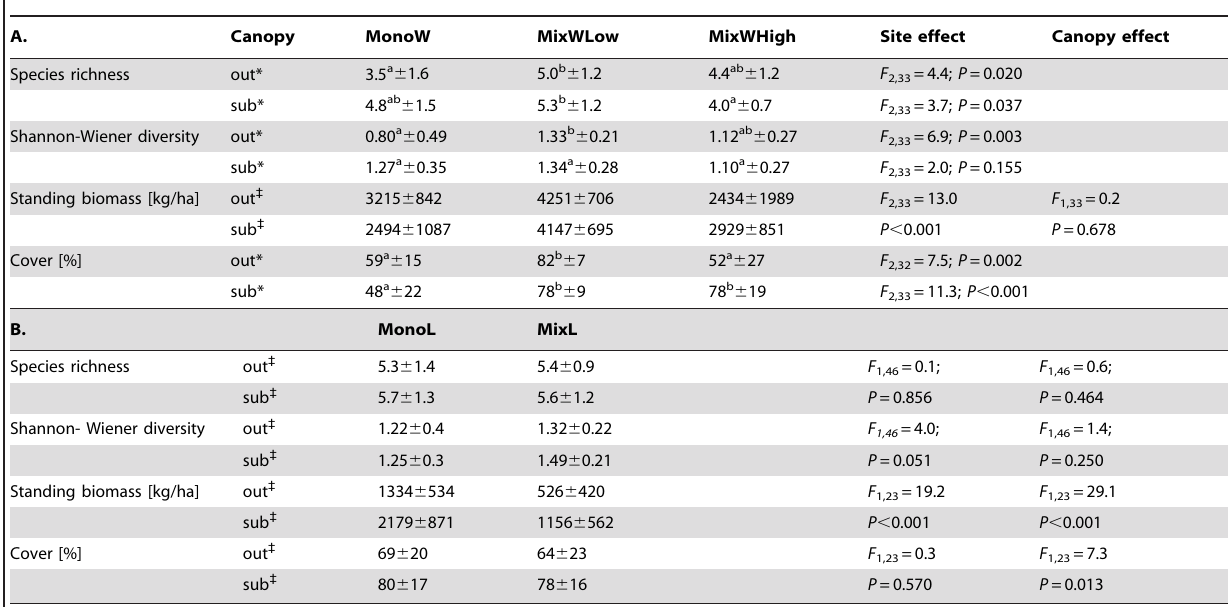
H3: High grass biomass, height and cover at mixed herbivore assemblage sites Within wildlife dominated sites, both standing herbaceous biomass and total herbaceous cover were significantly higher at Table 4. Mean values of herbaceous layer species richness, diversity, biomass and cover at wildlife (A) and livestock (B) sites (see Table 1 for abbreviations; in addition, ‘‘sub’’ represent sites influenced by tree canopies while ‘‘out’’ are sites outside the sphere of influence of tree